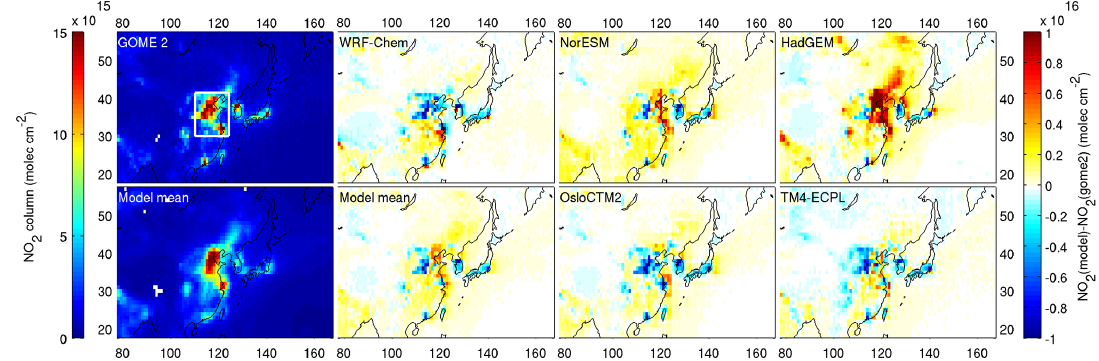
Figure 4. Mean tropospheric NO 2 columns in moleccm − 2 (between the ground and the tropopause height given in the GOME-2 product) in August and September 2008 over Asia as observed by the GOME-2 satellite and absolute differences between GOME-2 and model simulations (model names are given in the panels). Model mean tropospheric columns are also presented in the bottom left panel. The white square denotes the emission region discussed in the text. Table 5. Statistical parameters (correlation coefficient R , normalized mean bias NMB, root mean square error RMSE and normalized mean error NME) based on spatial variations for model simulations of NO 2 tropospheric columns over Asia and over Chinese emission area shown in Fig. 4 averaged over August and September 2008 compared to GOME-2 satellite observations.